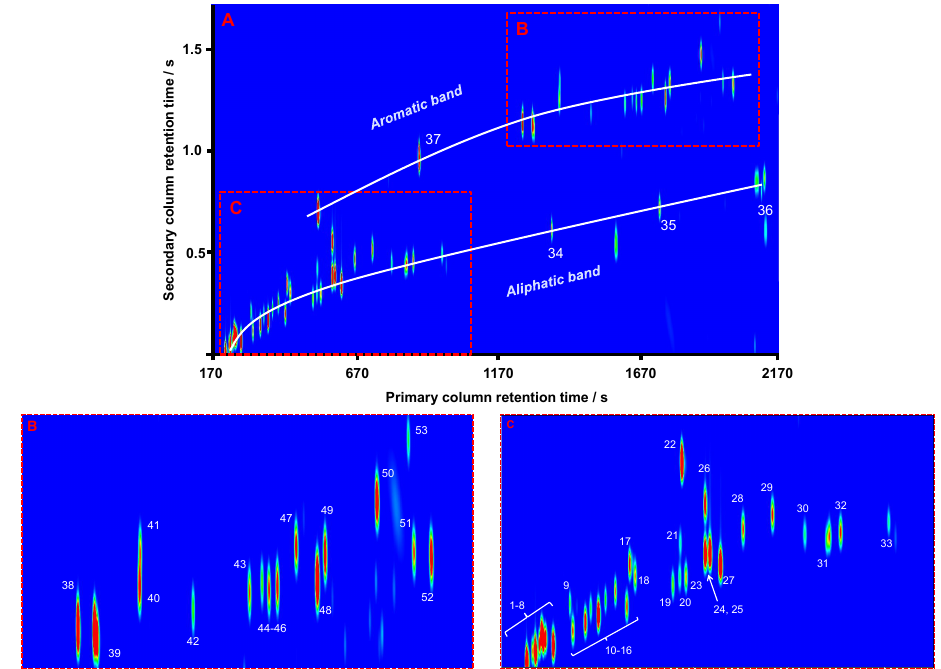
Fig.3. A.TD-GC × GC-TOFMSchromatogramoftheAR74HCstandard. Labelledpeaksareidentifiedasfollows: (34)nonane;(35)decane; (36) undecane and (37) toluene. Box B shows the aromatic region of the chromatogram. Labelled peaks are identified as follows: (38) ethyl benzene;(39)m/p-xylene;(40)o-xylene;(41)styrene;(42)isopropylbenzene;(43)propylbenzene;(44)3-ethyltoluene;(45)4-ethyltoluene; (46) 1,3,5-trimethylbenzene; (47) 2-ethyl toluene; (48) t-butylbenzene; (49) 1,2,4-trimethylbenzene; (50) 1,2,3-trimethylbenzene; (51) 1,3- diethylbenzene; (52) 1,4-diethylbenzene and (53) indane. Box C shows the aliphatic region. Labelled peaks are identified as follows: (1) 2-methylbutane; (2) pentane; (3) 1-pentene; (4) E-2-pentene; (5) isoprene; (6) Z-2-pentene; (7) 2-methyl-2-butene; (8) 2,2-dimethylbutane; (9) cyclopentene; (10) 2-methylpentane; (11) 3-methylpentane; (12) 2-methyl-1-pentene; (13) hexane; (14) E-2-hexene; (15) Z-2-hexene; pentene; (29) methylcyclohexane; (30) 2,3,4-trimethylpentane; (31) 2/4-methylheptane; (32) 3-methylheptane and (33) octane.